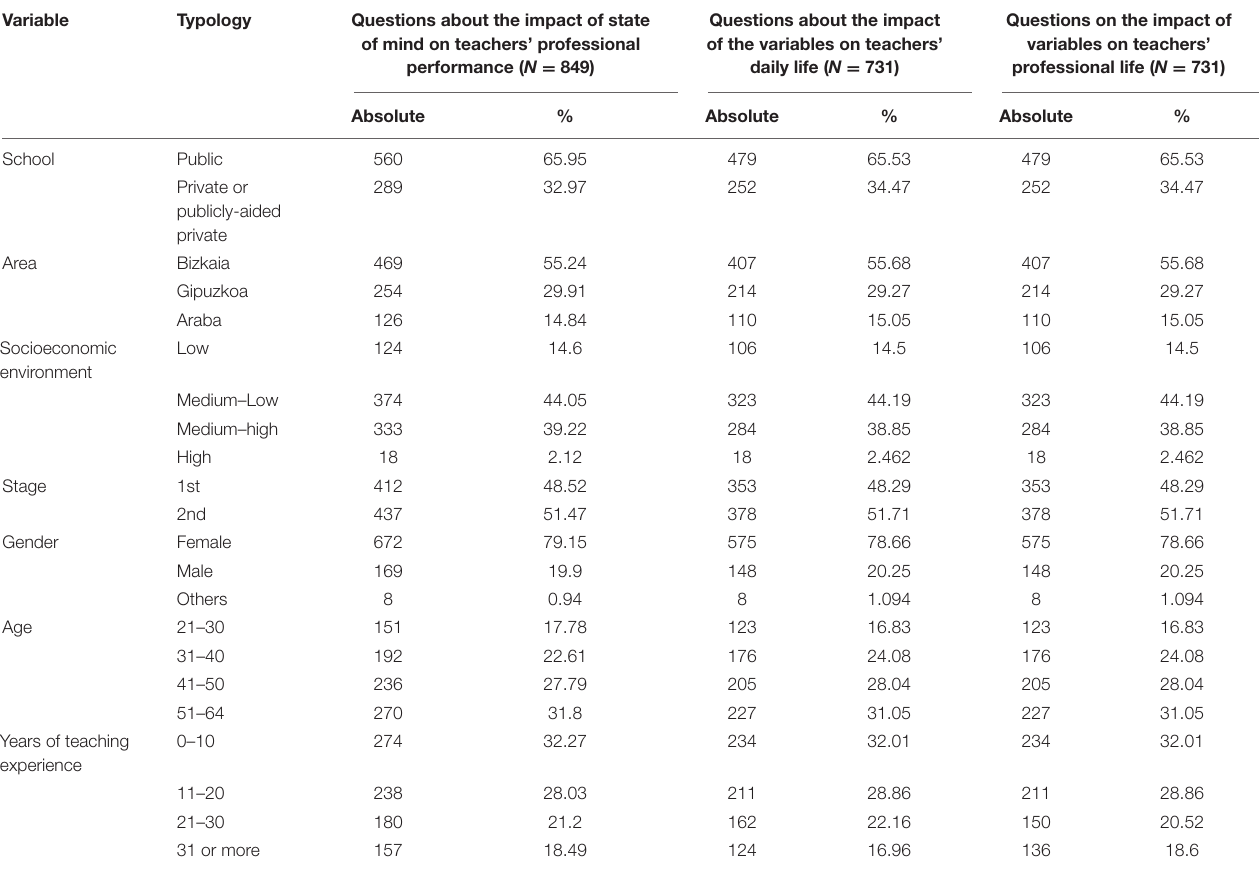
TABLE 1 | Participant sample.